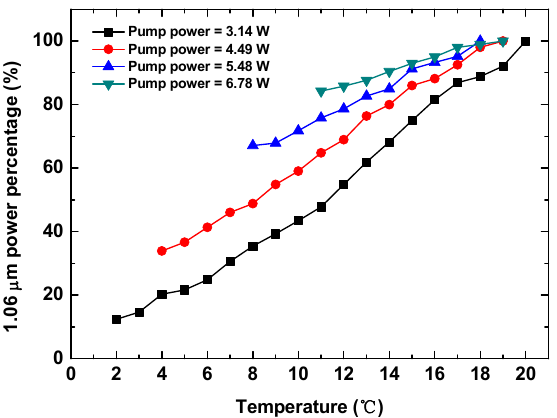
Figure 8. Tunable 1.06 μm power ratio in a dual-band (0.94 μm and 1.06 μm) Nd:GYSGG laser achieved via changing the working temperature [42].